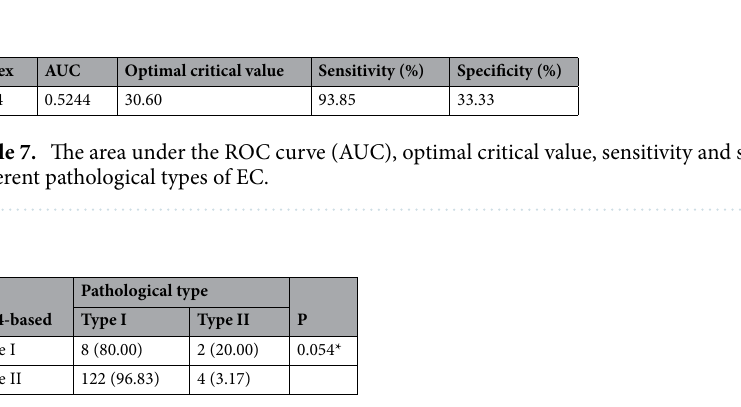
Table 8. Comparisons of the positive rates and levels of HE4 between the type I group and the type II group (n/%). *Fisher’s exact